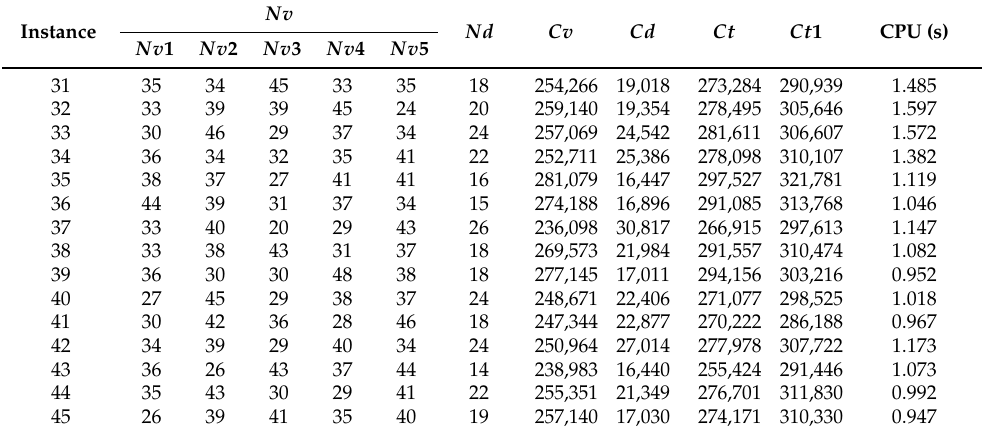
Table 3. Heuristic solutions for the 200-node